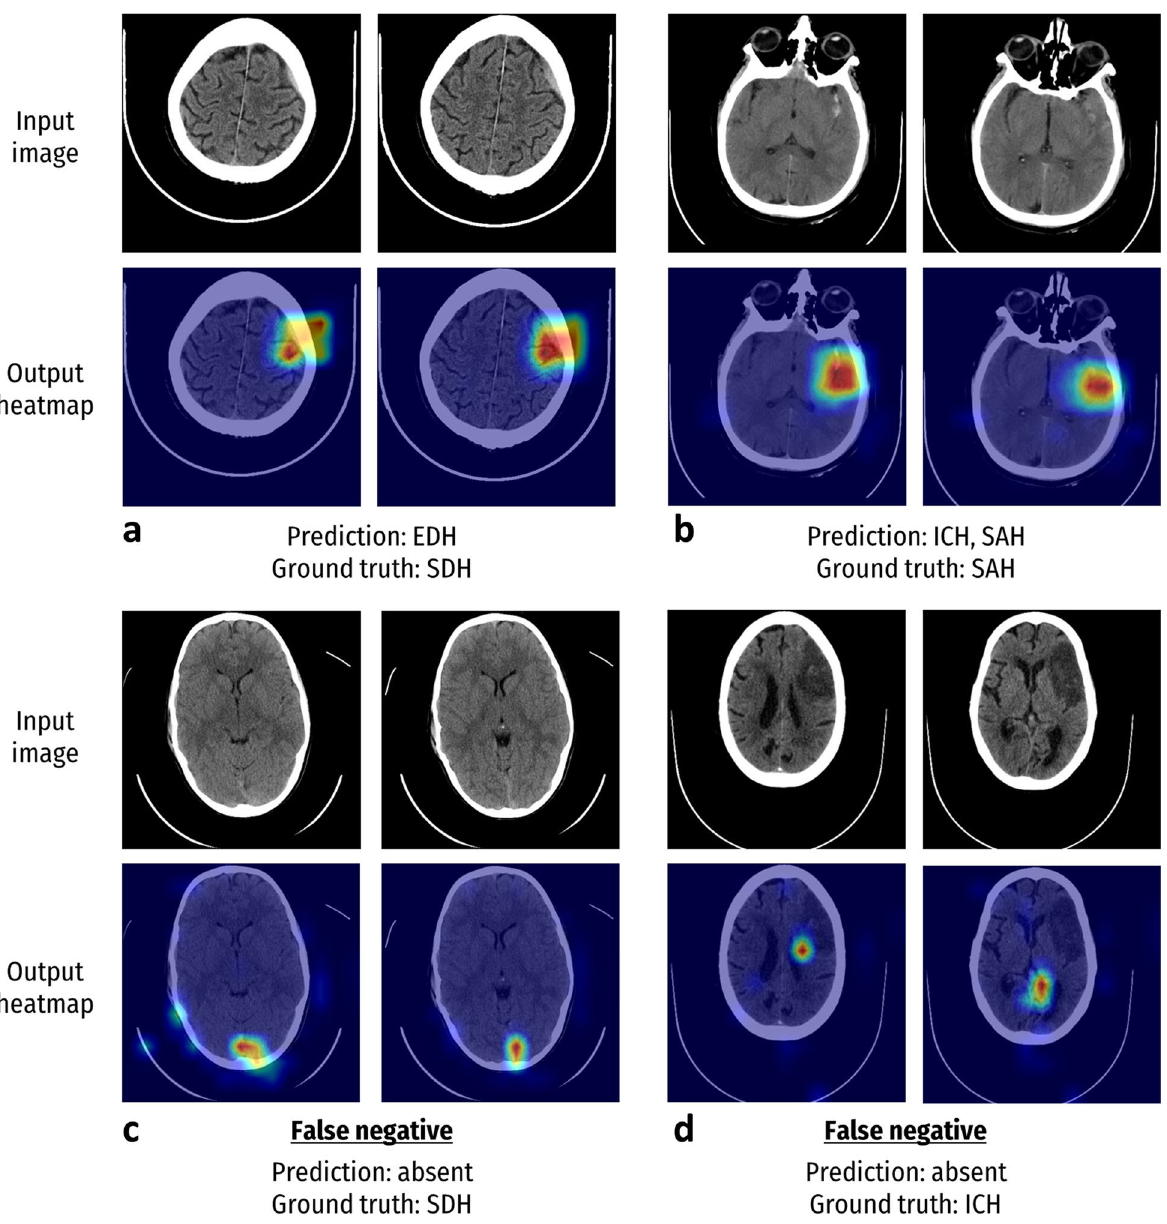
Fig. 4 Visualisation of incorrect model predictions using heatmap images. Examples of the regions which contributed to the model decision in predicting haemorrhages. The warmer the colour (red > orange > yellow > green > blue), the greater the contribution of the image pixel to the prediction. a The model predicted an EDH, whereas the ground truth consensus label determined by radiologists was an SDH. Notably, the haemorrhage had a biconvex shape more closely associated with EDHs. b The model predicted ICH and SAH. Although one radiologist identified both SAH and ICH, the ground truth consensus only indicated the presence of a SAH. However, there are several subtle areas indicating possible ICH. c False negative in which the model missed a SDH. Although the model detected a suspicious area as indicated on the heatmap, it did not reach a sufficient threshold to be classified as a haemorrhage. Stagnant blood in the dural sinuses, which are benign and more common, can appear similar to SDH in this area, which may have contributed to the model error. d False negative in which the model missed an ICH. The heatmap indicated that the model did not appropriately detect areas of abnormality. The presence of chronic infarction here may have affected the model performance. EDH Extradural haemorrhage, ICH Intracerebral haemorrhage, IVH Intraventricular haemorrhage, SDH Subdural